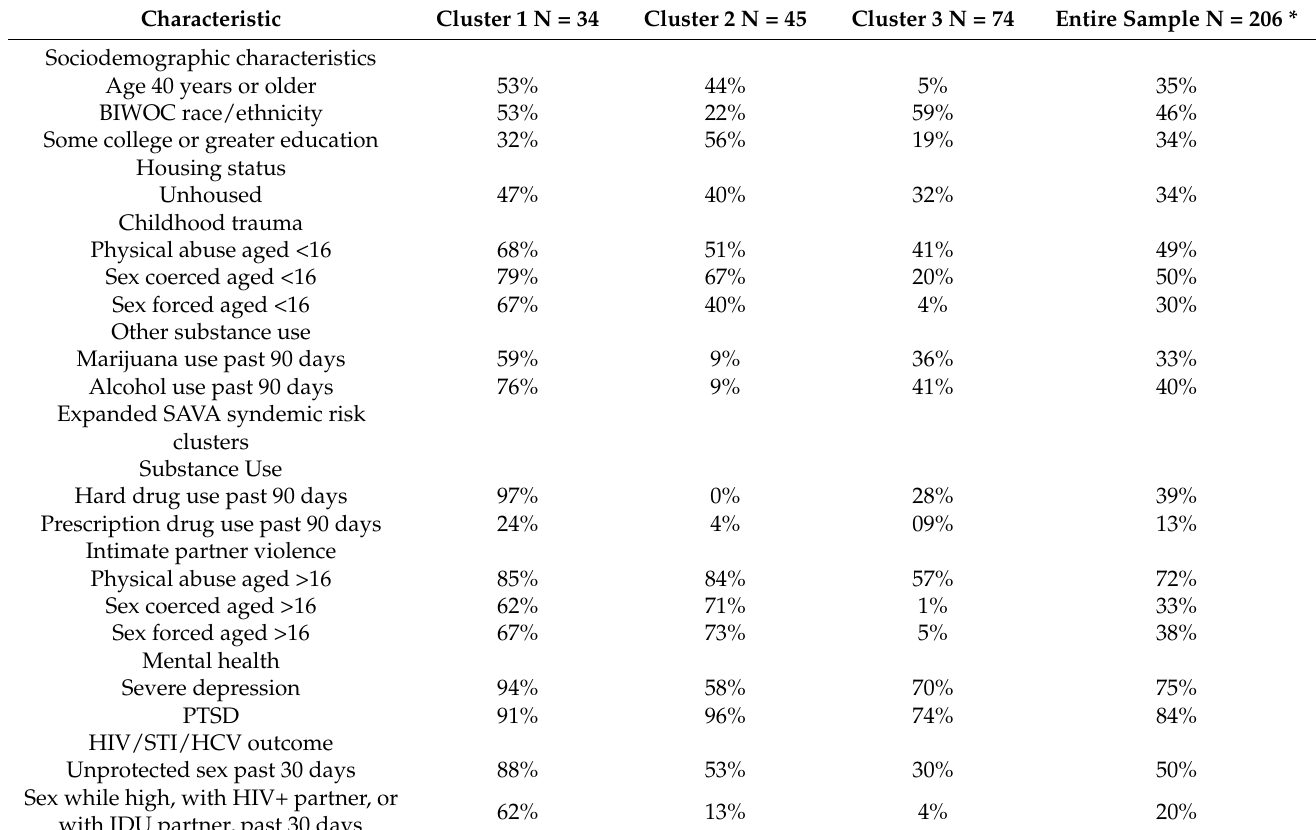
Table 2. Expanded baseline SAVA syndemic risk clusters and HIV/STI/HCV